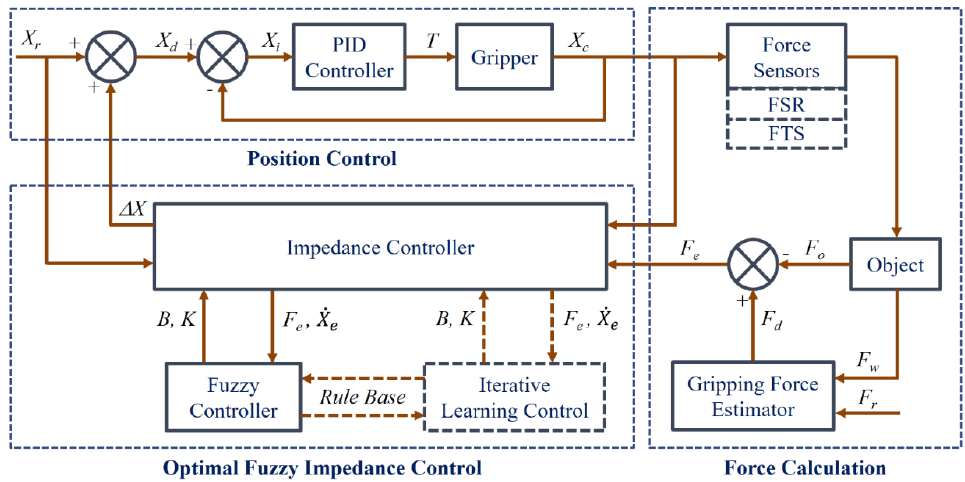
Figure 2. The architecture of the optimal fuzzy impedance control for the gripper.